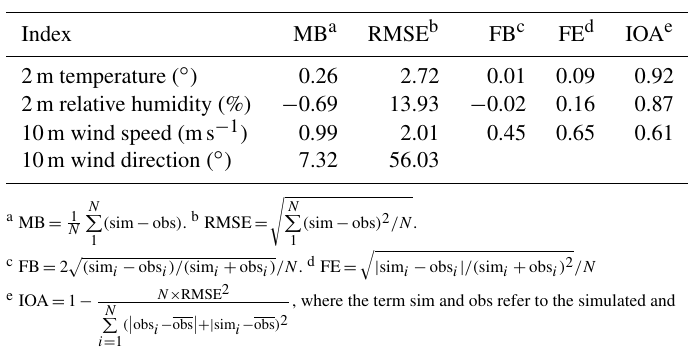
Table 3. Statistical analyses of the simulated meteorological variables versus the ground observations. MB, mean bias; RMSE, root-mean- square error; FB, fractional bias; FE, fractional error; IOA, index of